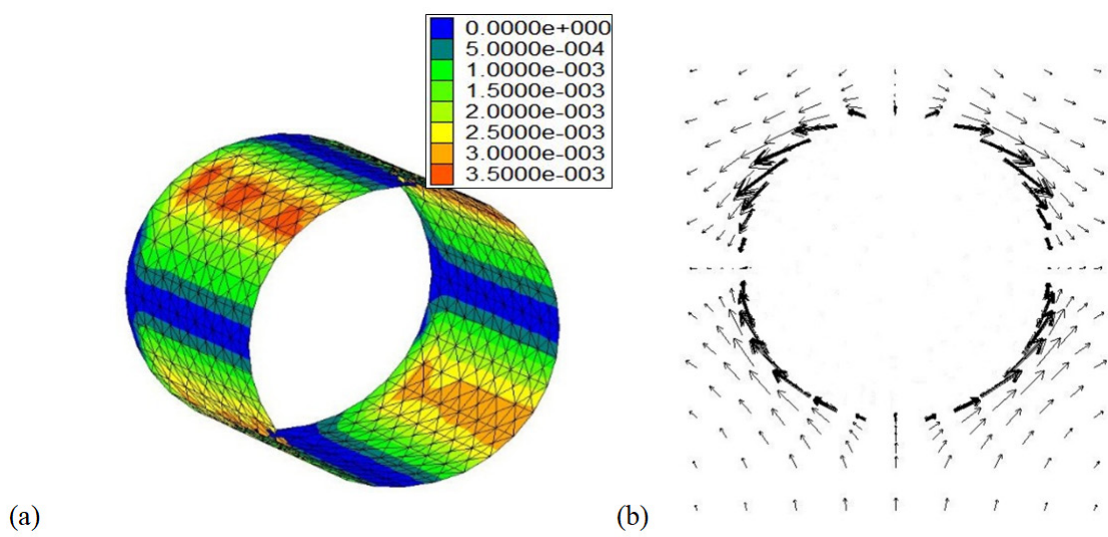
Figure 9: Performance of FLAC-3D interface element: (a) tangential displacement on the interface element (units: m) and (b) ground movements around the tunnel